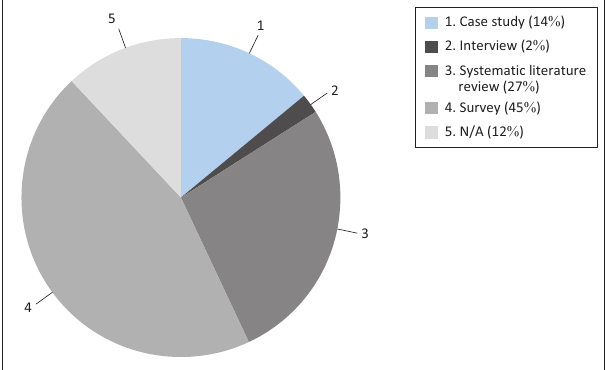
FIGURE 4: Articles by research design.